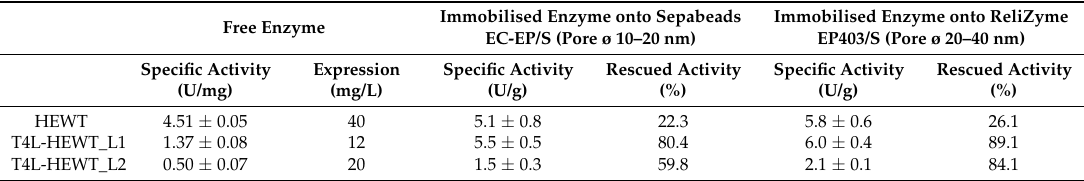
Table 1. Comparison of specific activities and expression levels of the original Halomonas elongata aminotransferases (HEWT) and the two chimeric proteins in the free enzyme form. Specific activities of the resin following immobilisation of enzymes (5 mg enzyme /g resin ), and percentage of residual activity after immobilisation (24 h, room temperature, in 50 mM phosphate buffer pH 8) with respect to the free protein.